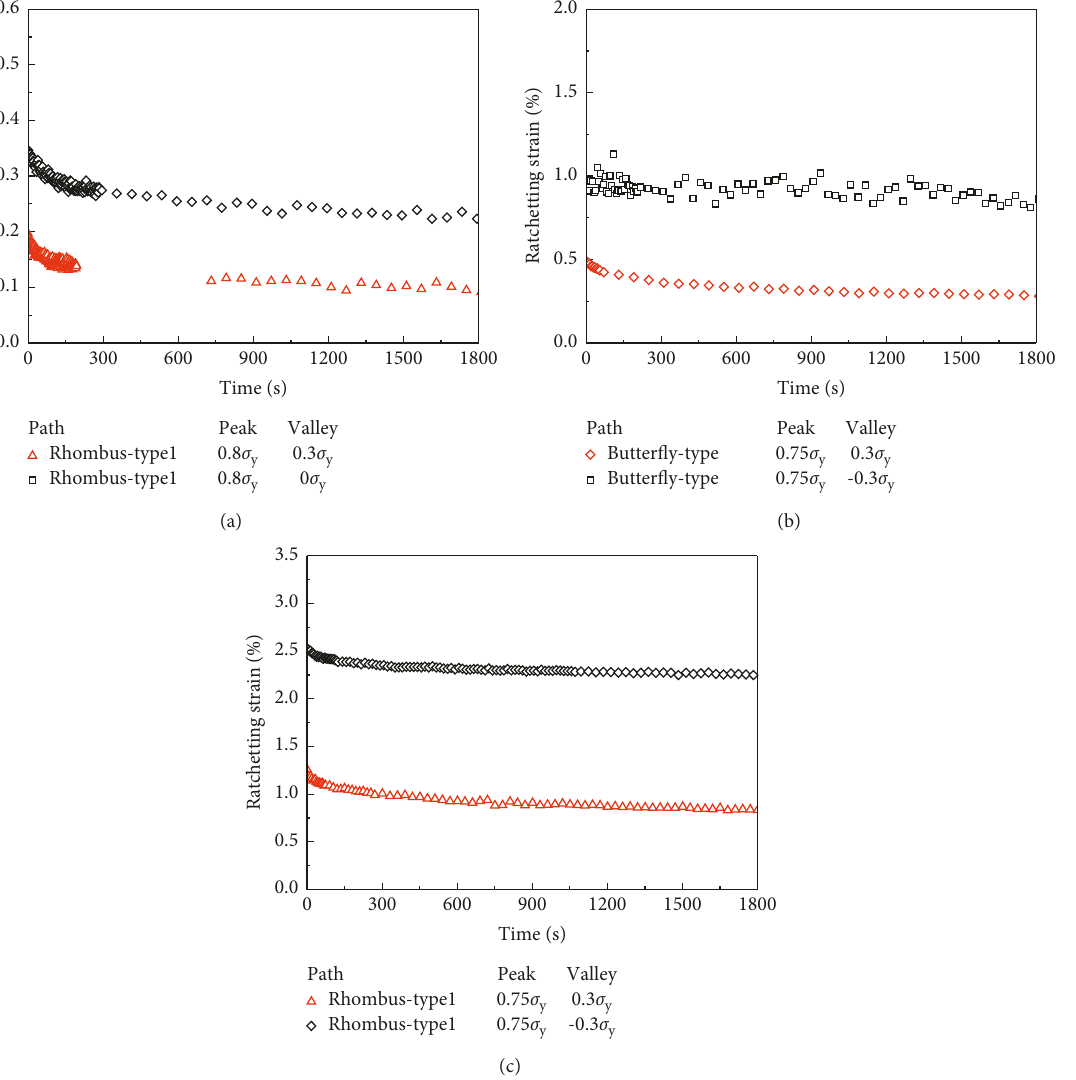
Figure 9: The axial strain evolving with time during the zero-stress holding after the multiaxial ratchetting tests of PC at different temperatures: (a) 35 ° C, (b) 60 ° C, and (c) 90 °